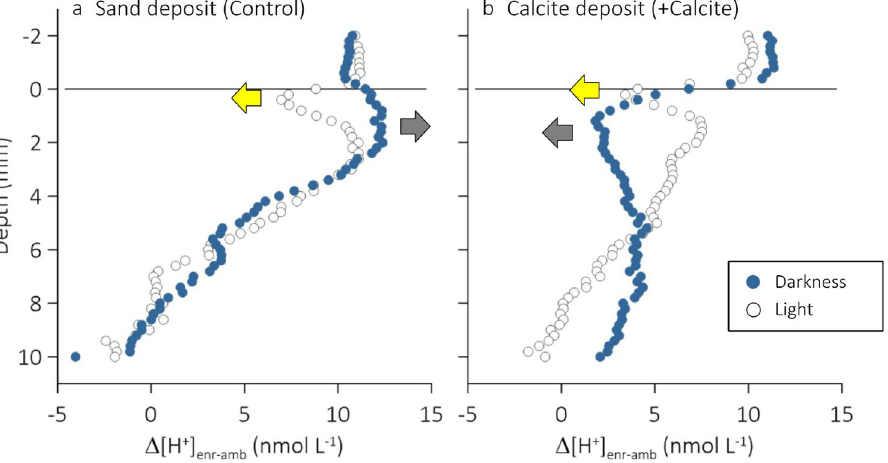
Figure 5. Effect of seawater CO 2 enrichment on the sediment porewater [H + ] (Δ[H + ] enr-amb , nmol L −1 ) under conditions of light (open symbols; yellow arrow) and darkness (closed symbols; shaded arrow) and added ( a ) sterile sand (Control) or ( b ) calcite